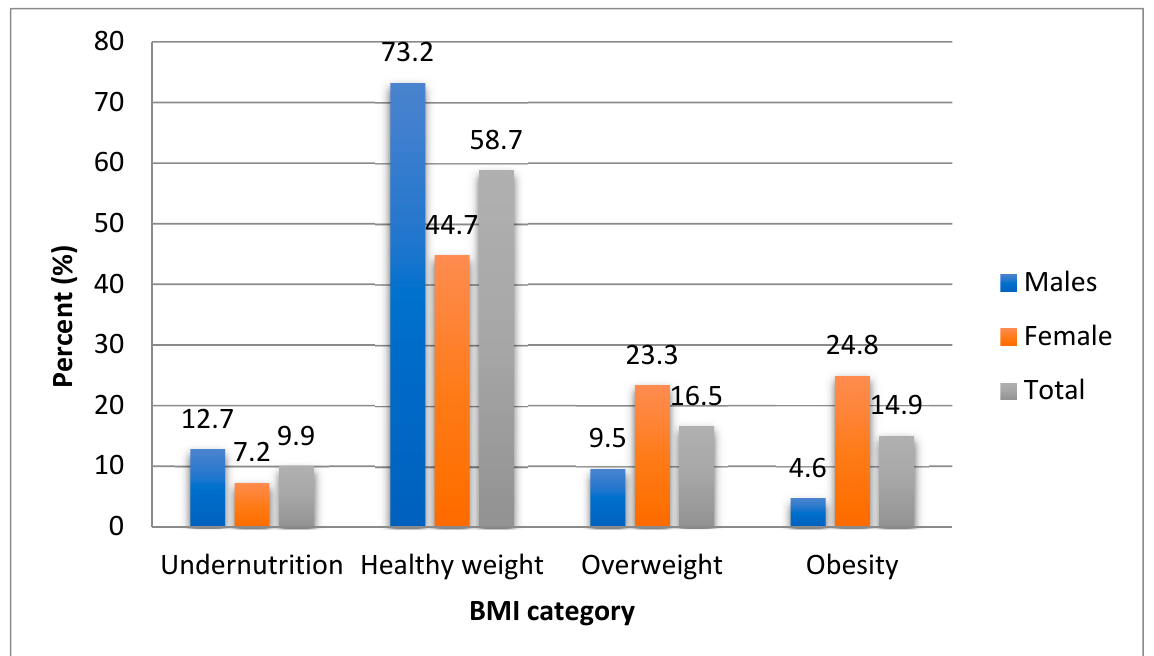
Figure 2. Shows the prevalence of malnutrition in Ellisras young adult males and females aged 21–30 years. Table 2 indicates a correlation between Conicity Index and FBG (0.141 males, − 0.185 fe- males), insulin (0.143 males, 0.185 females), and TG levels (0.253 males, 0.237 females) which were not significantly different among genders except for insulin. Conicity Index was, furthermore, significantly associated with PR, BMI, and HDL-C (0.167, 0.150, and − 0.253, respectively) in males. ABSI was only significantly associated with TG ( − 0.109 males, 0.120 females). Furthermore, there was a correlation between ABSI and LDL-C (0.152) in females and PR (0.148) in males. BRI was significantly correlated with insulin (0.252 males, females 0.255), HOMA- β (0.250 males, females 0.245), and TG (0.310 males, females 0.216). On another hand, HDL-C ( − 0.196) and BMI (0.144) were significantly associated with BRI in males only. There was no correlation between all anthropometric indices and both SBP and DBP in both genders. Table 3 shows the significant associations between anthropometric indices and various cardiovascular risk factors, unadjusted and adjusted for age and gender. Conicity Index was significantly associated with PR ( β 0.099, 95% CI 0.017 0.143, p < 0.013; β 0.081, 95% Table 2. Pearson correlation for anthropometric indices and cardiovascular risk factors of Ellisras young adults aged 21–30 years.